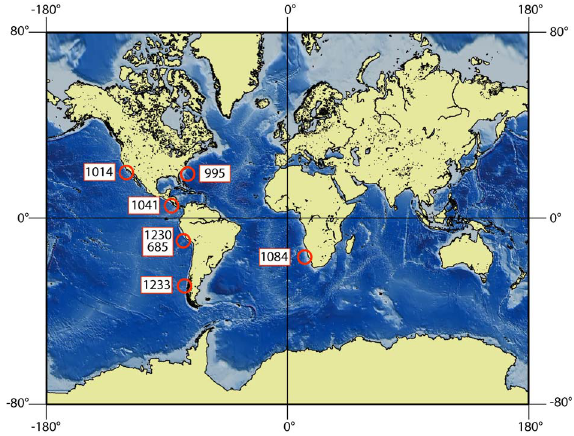
Fig. 1. Location of the ODP Sites used for the validation test Figure 1. Location of the ODP Sites used for the validation test of the numerical model: Blake of the numerical model: Blake Ridge (Site 995), Califormia (Site Ridge (Site 995), Califormia (Site 1014), Costa Rica (Site 1041), Namibia (Site 1084), Peru 1014), Costa Rica (Site 1041), Namibia (Site 1084), Peru (Sites 685, 1230), and Chile (Site (Sites 685, 1230), and Chile (Site 1233).